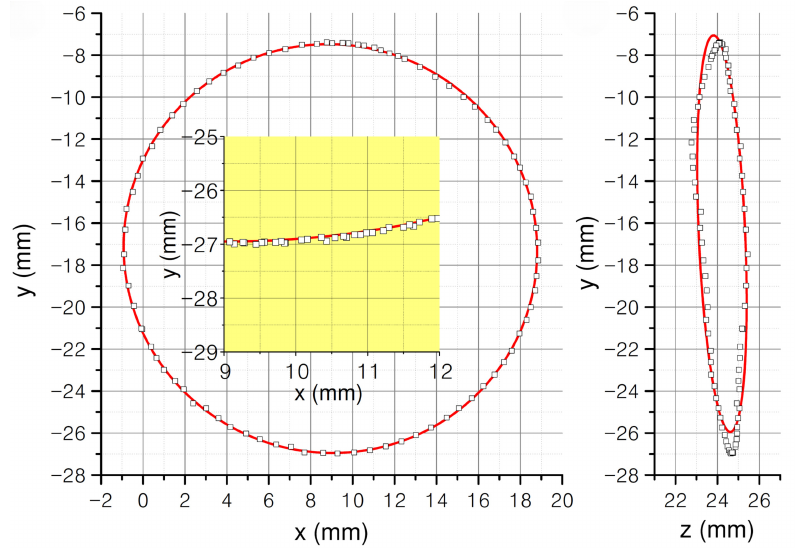
Figure 3. Projections on the xy e zy planes of a 8P reconstructed circular trajectory. The red curves are elliptical best-fits. Residuals as small al 6.1 µ m and 92 µ m are obtained, respectively. The corresponding 9P analysis lead to results that are similar (5.6 µ m) in the xy projection and worse (95 µ m) in the xy